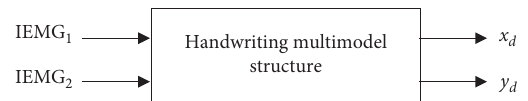
Figure 5: Inputs/outputs of the multimodel handwriting structure.